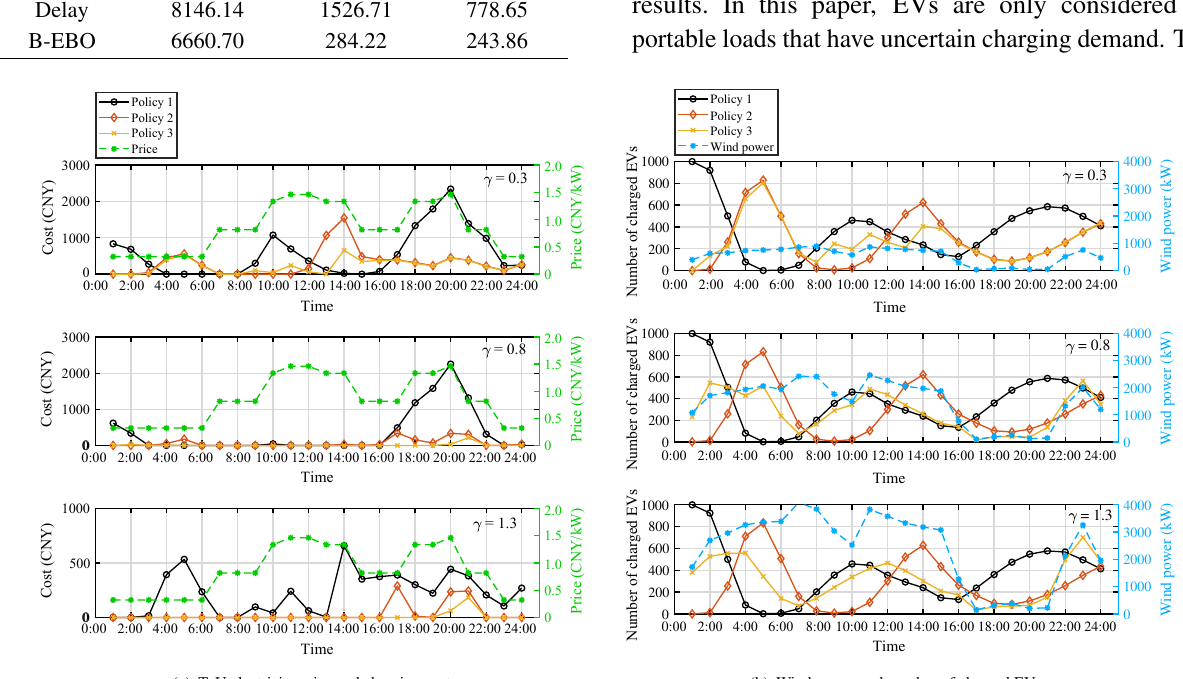
Fig. 7 Simulation results under different wind power